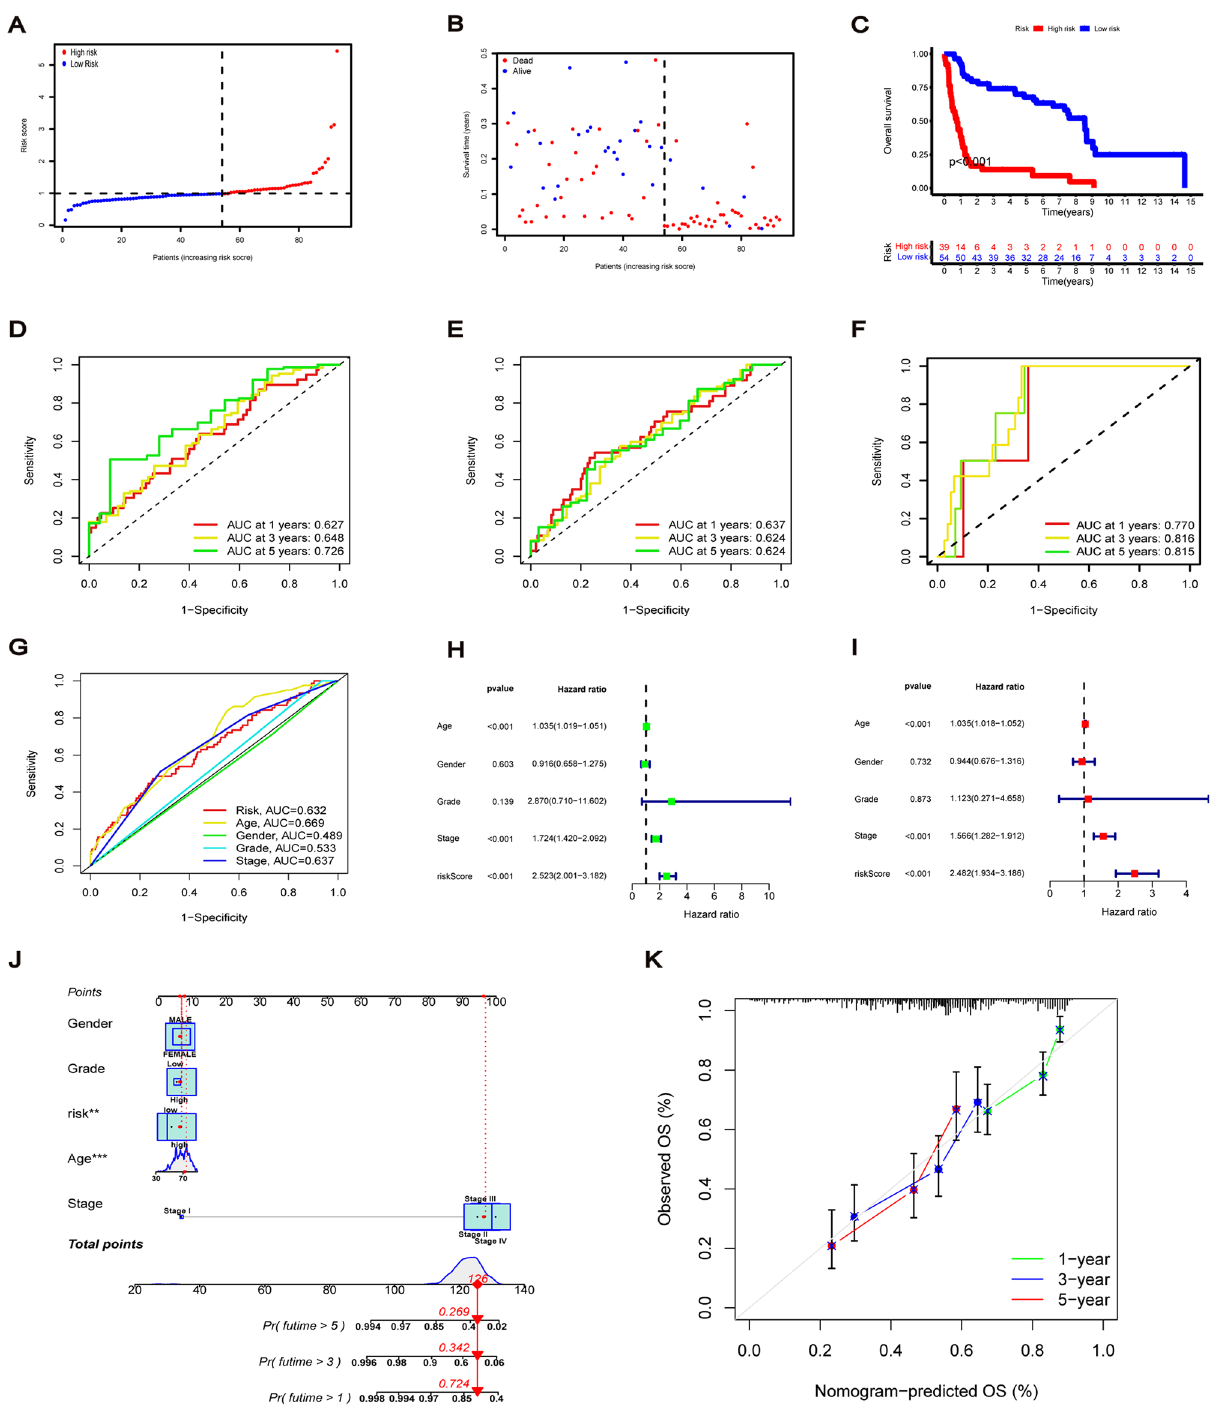
Figure 6. Prognostic value of risk signature. ( A ) BC patients in GSE31684 cohort divided into low-risk and high-risk subgroups according to the median risk score. ( B ) The survival status of each patient with different risk in GSE31684 cohort. ( C ) Kaplan–Meier curves of OS in different risk groups of GSE31684 cohort. ( D – F ) ROC curves of 1-year, 3-year, and 5-year survival rate for the risk signature in train, test and GSE31684 cohort. ( G ) ROC curves of risk score and clinicopathologic features on the 3-year. ( H ) Univariate Cox regression for risk score and the clinicopathological features. ( I ) Multivariate Cox regression for risk score and the clinicopathological features. ( J ) Nomogram for predicting 1-year, 3-year and 5-year survival rates of BC patients. ( K ) The calibration curves validate the consistency between the actual outcome and the predicted result for 1-year, 3-year and 5-year survival